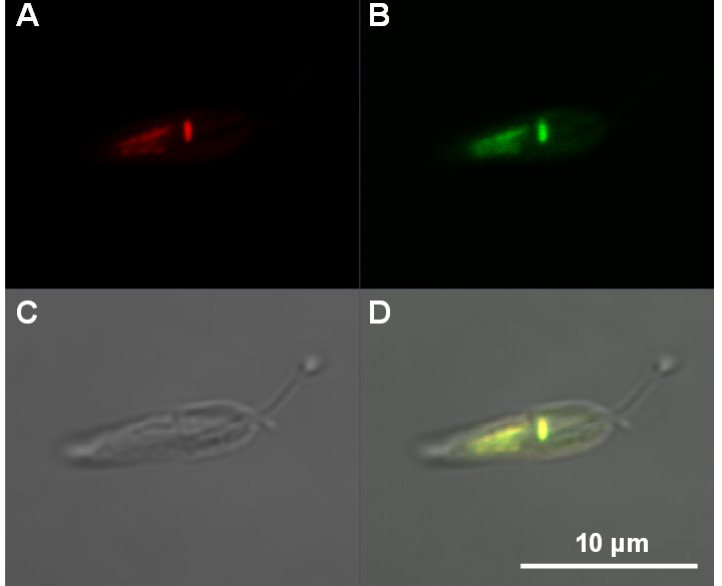
Figure 6. Transduction of ATTO488-BSA into Leishmania tarentolae using MPG α . Live cell imaging of the internalized cargo was performed by laser-scanning confocal fluorescence microscopy. DAPI was used for staining of double-stranded DNA (false- colored in red). Colocalization of ATTO488 and DAPI fluorescence is found in the kinetoplast and the nucleus, indicating that MPG α transports ATTO488-BSA into both cell organelles. The fluorescence images represent a mid-nuclear confocal section. A: DAPI staining of cellular DNA (false-colored in red), B: ATTO488-BSA, C: Differential interference contrast, D: